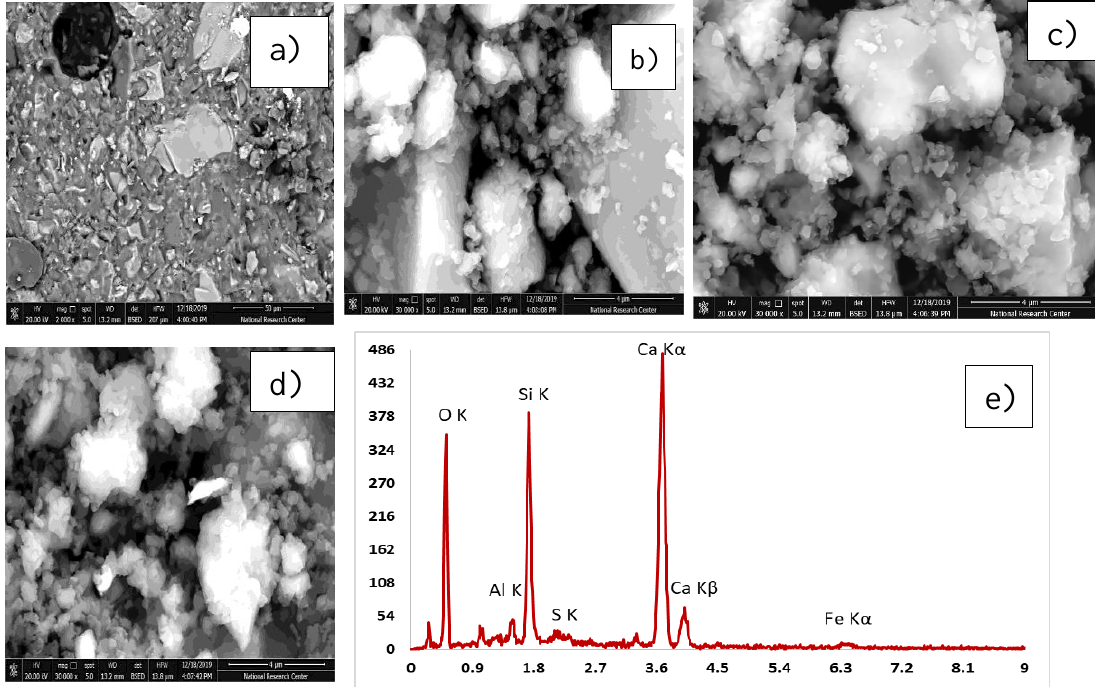
Figure 14. SEM and ( a – d ) SEM images at different magnification factor and ( e ) EDX for the UHPC mix incorporating 1% nano-waste glass.